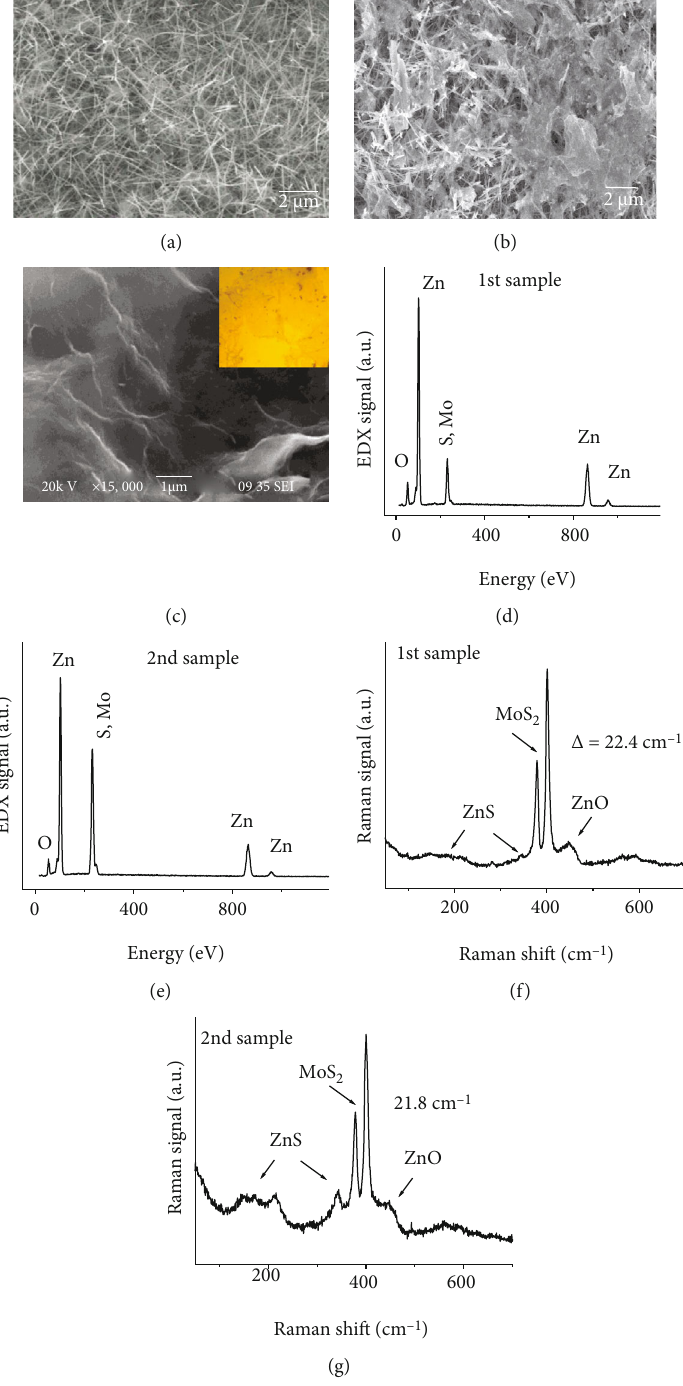
, and MoS samples; inset is an optical microscopy image of MoS 2 2 where MoS was prepared with 2 and 6 spin coating runs of deposition, 2 2